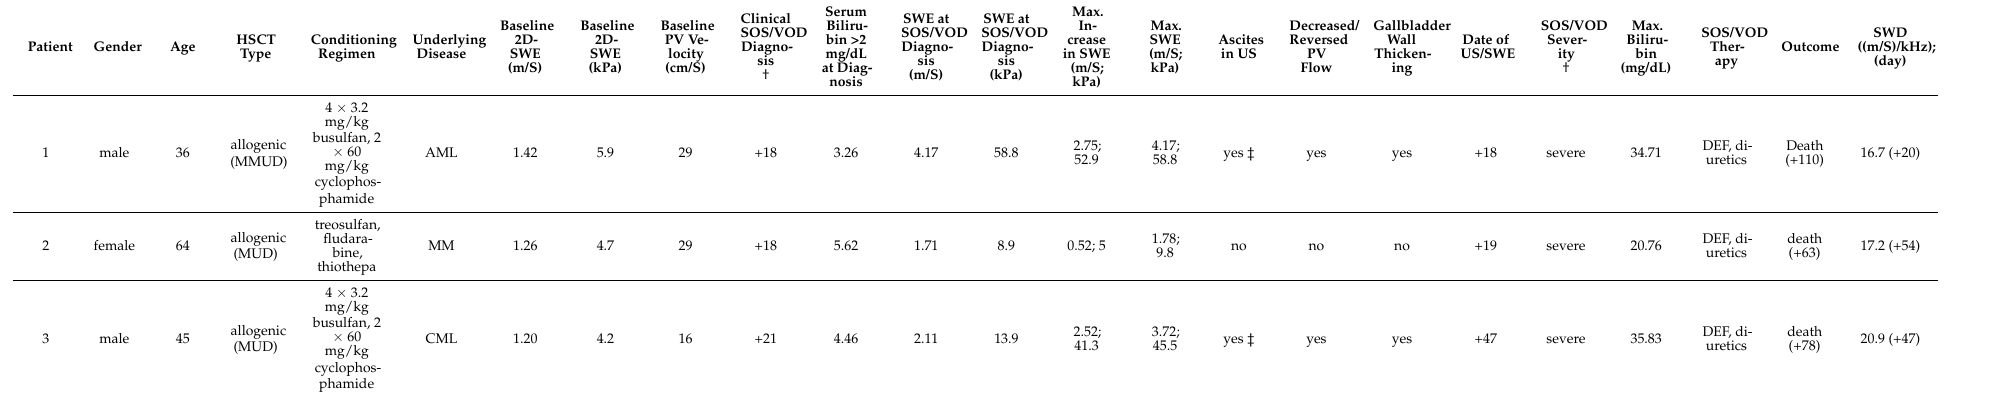
Table 2. Characteristics of SOS/VOD